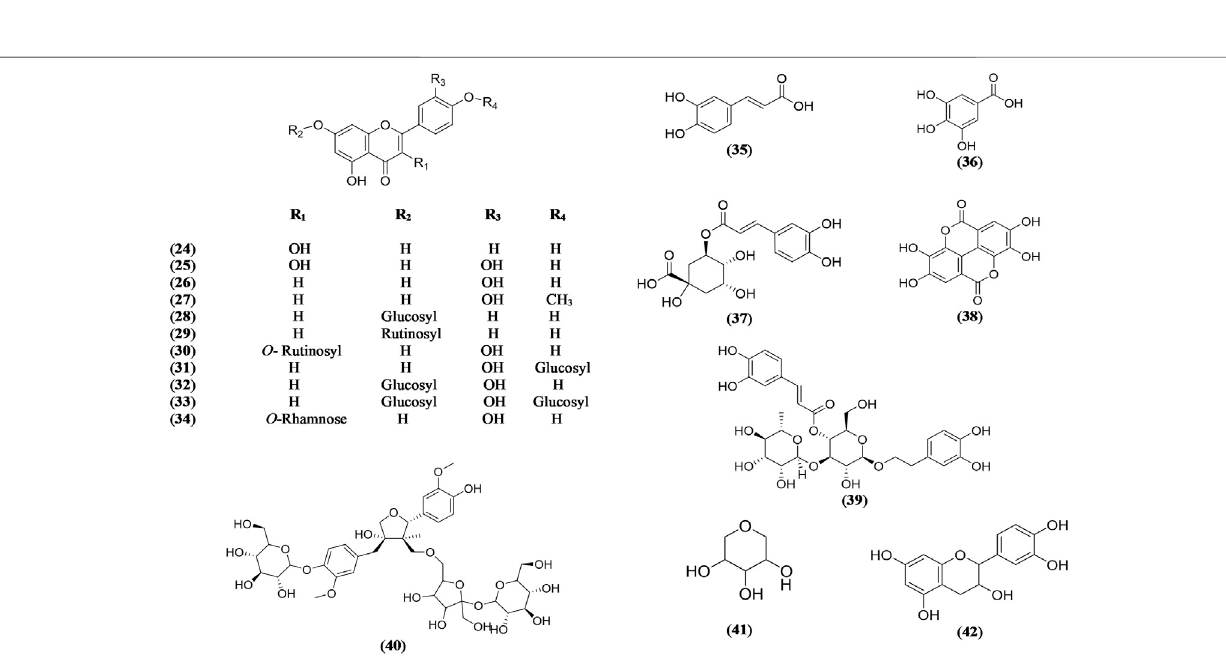
Frontiers in Pharmacology |